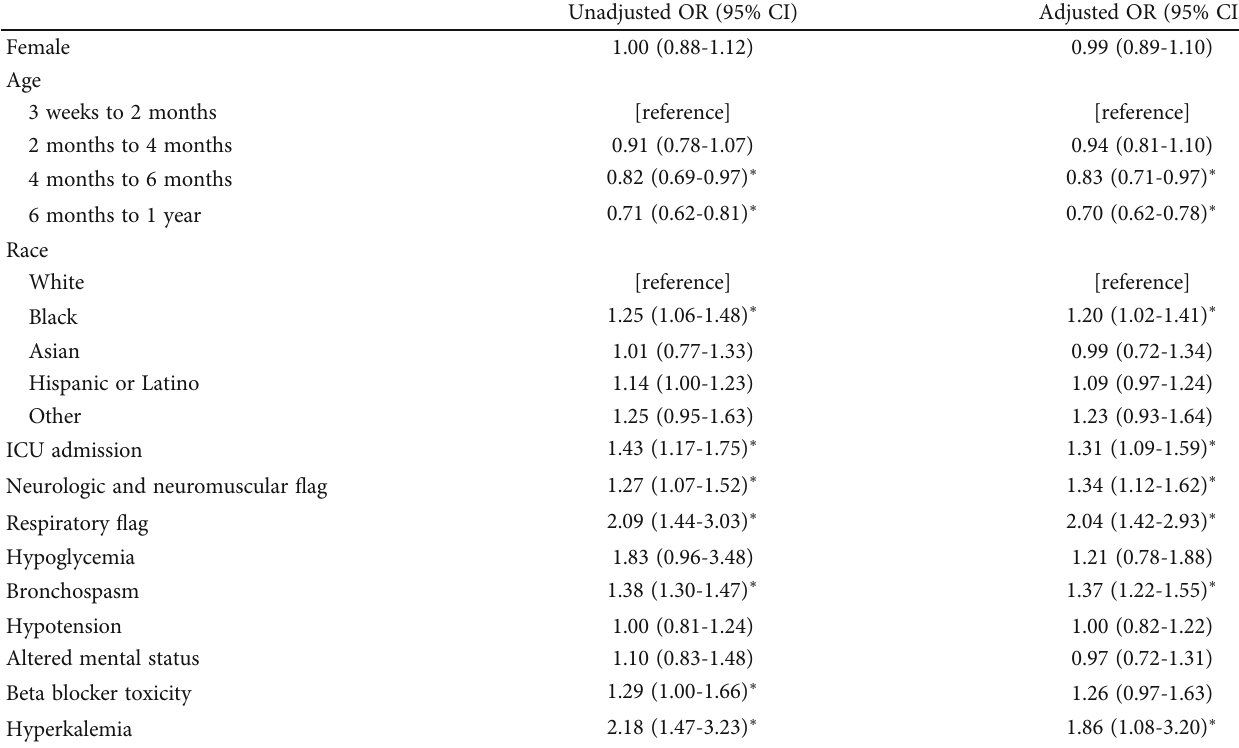
Table 3: Odds ratios for length of stay of inpatient infantile hemangioma